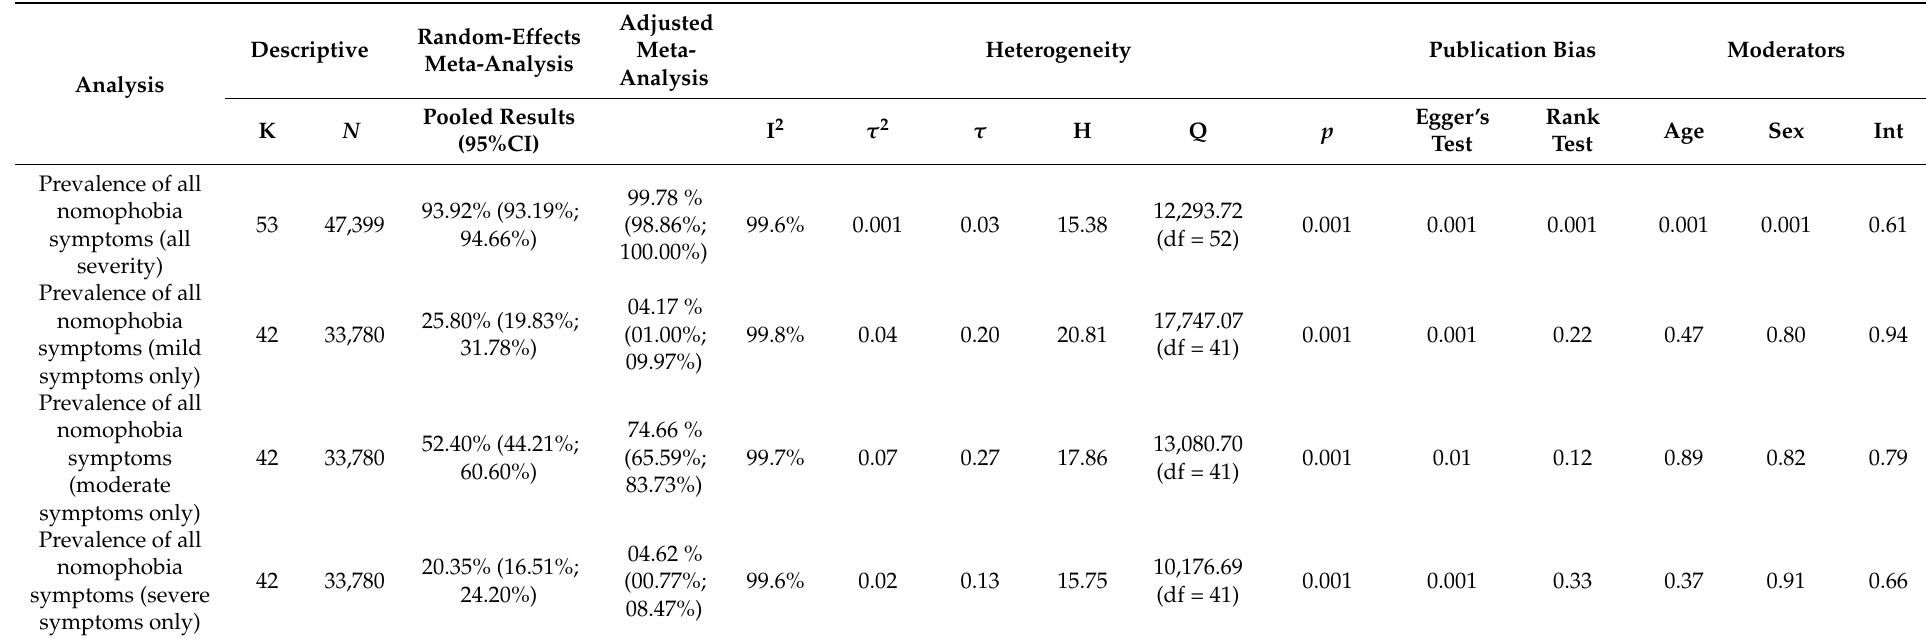
Table 2. Results of the random-effects meta-analysis models of the prevalence of nomophobia